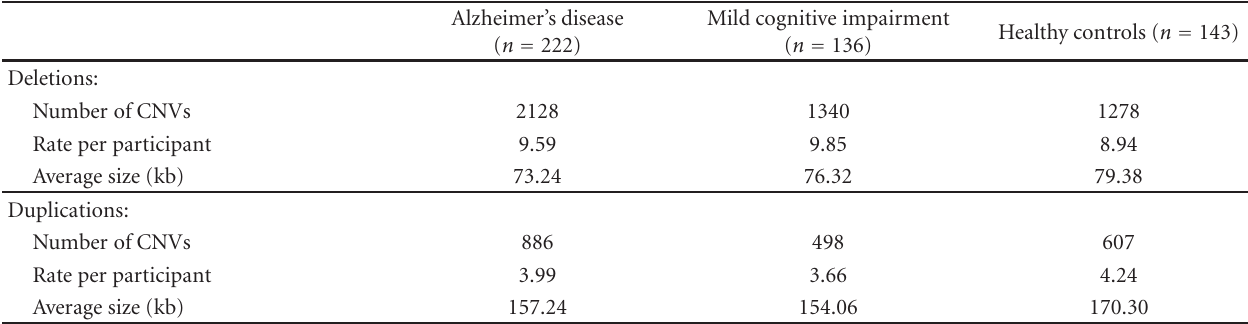
Table 2: Characteristics of CNV calls in the three diagnostic